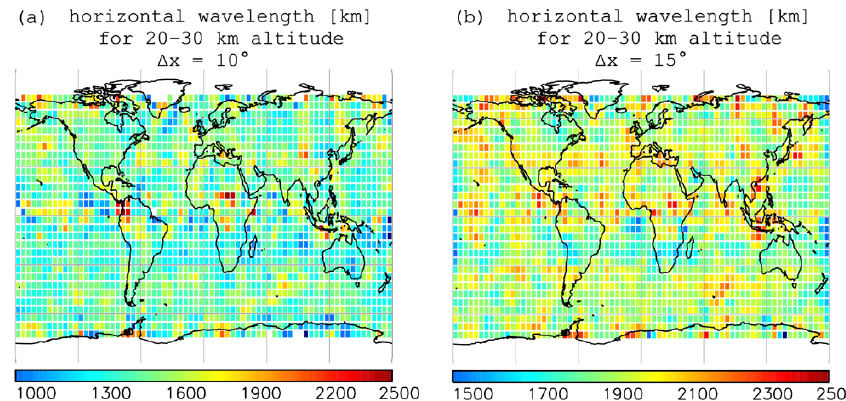
Fig. 6. Horizontal wavelength derived from 3 points of COSMIC RO temperature profiles for the NH winter 2006/2007. Sensitivity of the horizontal wavelength regarding distance in spacing between the 3 points for 10 ◦ (a) and 15 ◦ (b) spatial interval are displayed. Note, that the color scale in (a) and (b) is different.